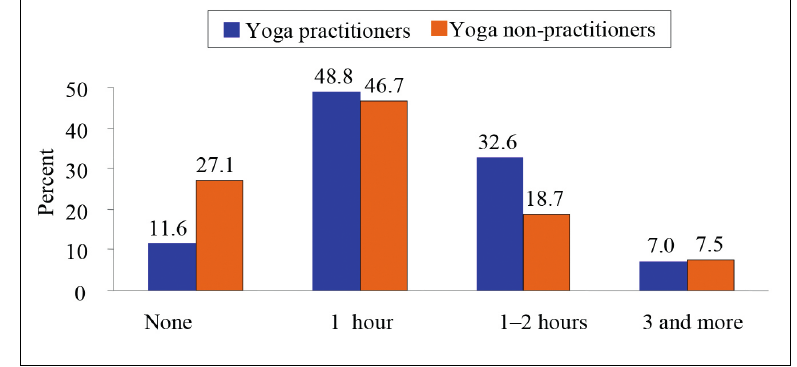
Note. x ² = 9, df = 3, p <